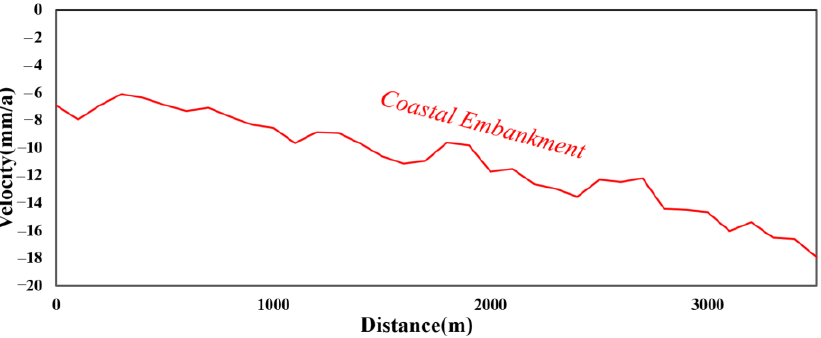
Figure 6. The statistics of the deformation rate in the LOS direction of the coastal embankment from south to north (x-axis is the distance from the coherence point to the starting point of the south). The results show that the deformation rate on the north side of the coastal embankment is larger than that on the south side, see Figure 6. The deformation rate of the coastal embankment is continuous. Since there are no GPS measurements or leveling data on the coastal embankment section, the deformation results derived from InSAR technology provide useful data for the study of settlements in the area.